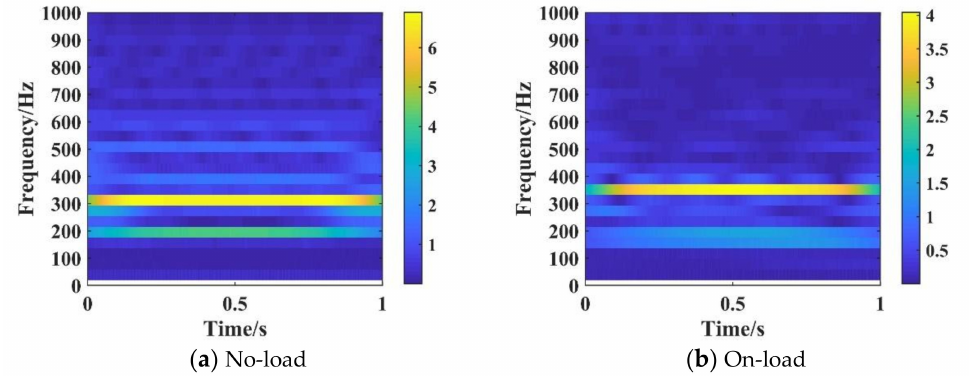
Figure 4. Typical wavelet time frequency energy spectrum of vibration signal of converter